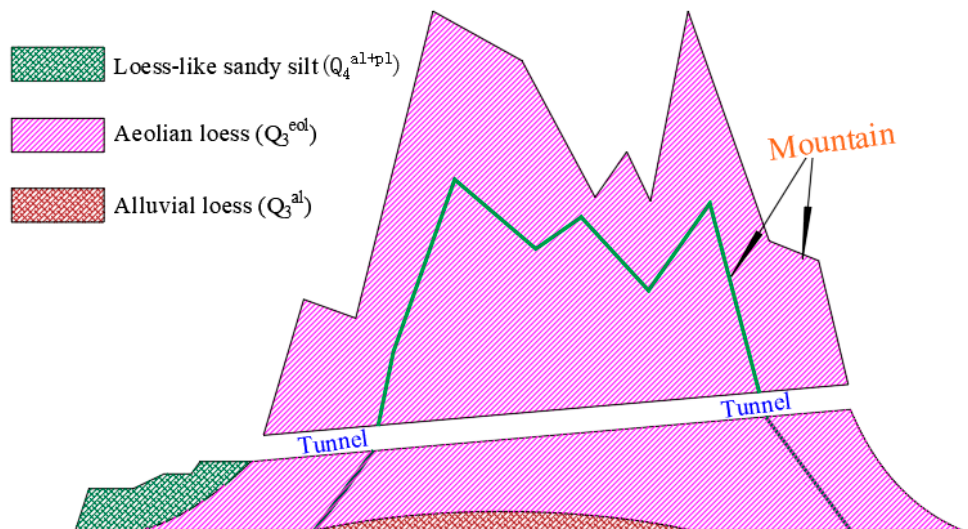
Figure 1. Geological condition of the site.